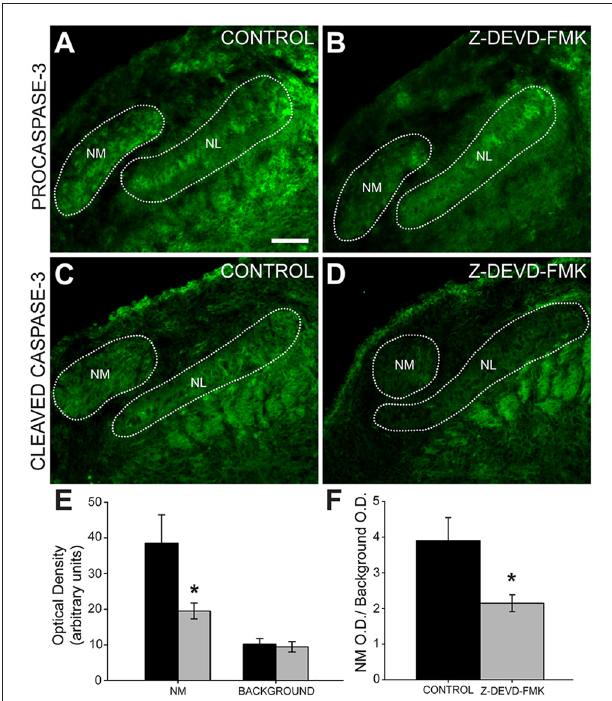
FIGURE 3 | Cleaved caspase-3 expression is reduced in Z-DEVD-FMK injected animals. (A) NM cell bodies, NL cell bodies, NL dendrites and cells in the glial margin express procaspase-3 in control embryos and (B) Z-DEVD-FMK injected embryos. (C) In tissue from control animals, cleaved caspase-3 is expressed in NM and in NL dendrites. (D) In tissue from embryos that received injections of Z-DEVD-FMK into the IVth ventricle, cleaved caspase-3 expression was reduced. (E) While background optical density values did not differ, values in NM were significantly lower in treated vs. control embryos ( ∗ p < 0.5, t -test). (F) Quantification of cleaved caspase-3 expression showed that optical density measured in NM was significantly reduced in Z-DEVD-FMK injected embryos relative to background levels in an unlabeled area dorsolateral to NM ( ∗ p < 0.5, t -test). Scale bar in (A) = 100 µ m, applies to (A–D)